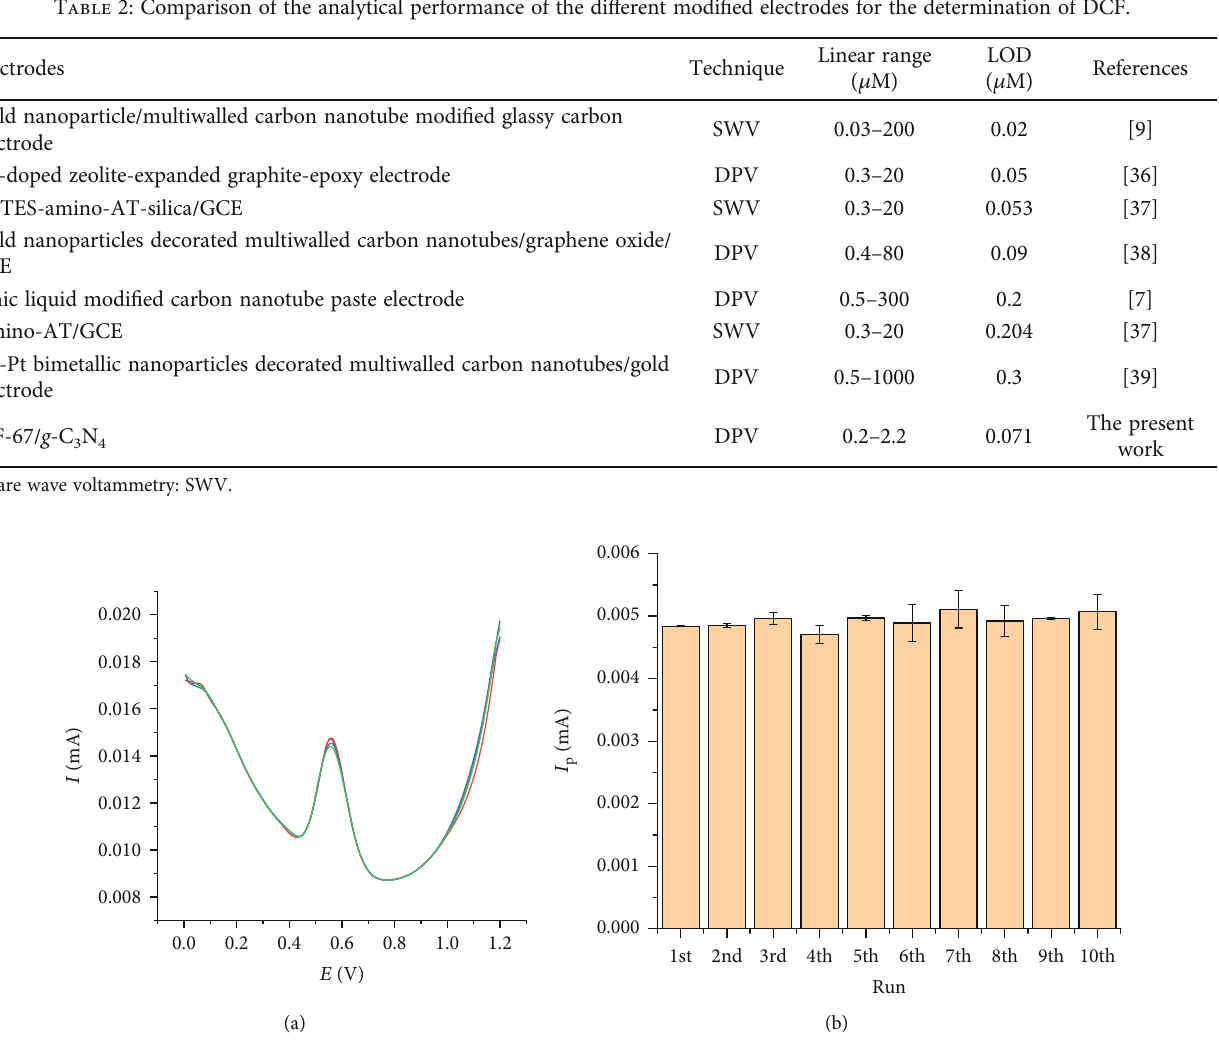
Figure 12: The DPV of four replicates measurement (a) and the values of peak current of DCF on ZC-GCE modi fi ed using (5 μ L ZC (1 mg/mL) for ten times on the same electrode (b). Table 3: E ff ect of some foreign substances on the determination